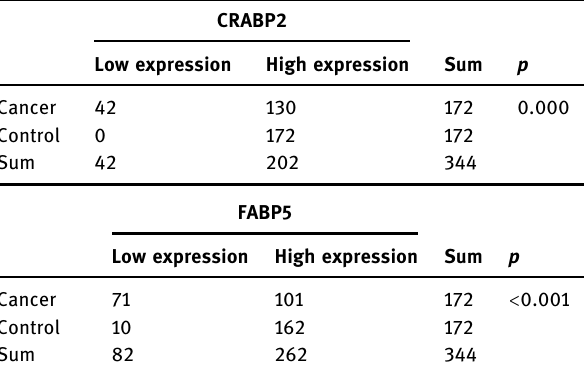
Table 2: Expression of CRABP2 and FABP5 in ESCC and adjacent tissues